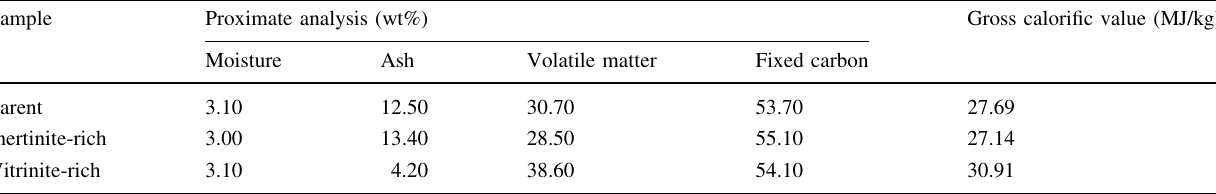
Table 1 Proximate analysis and calorific value (CV) (air dried) of the parent, inertinite-rich, and vitrinite-rich samples